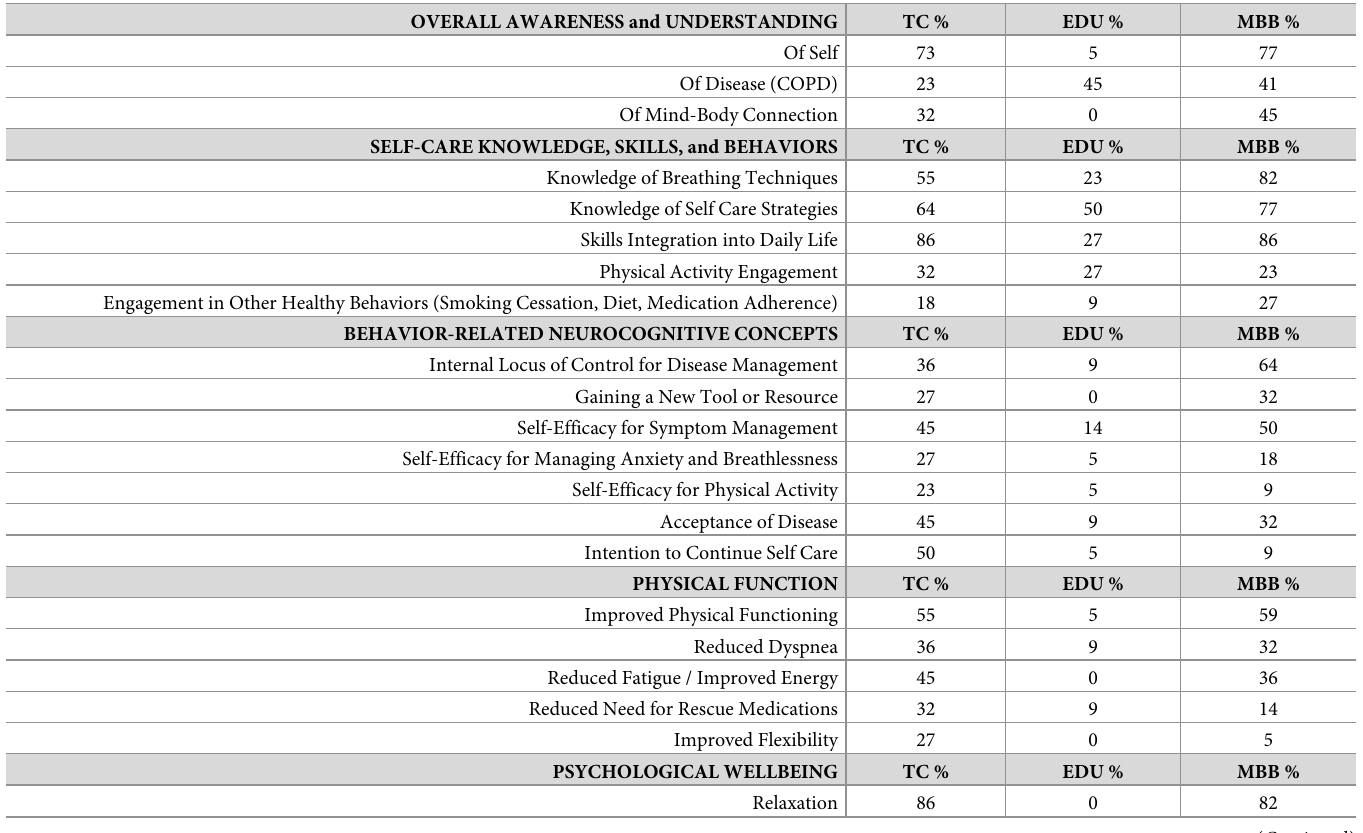
Table 1. Percent of individuals per group endorsing emergent